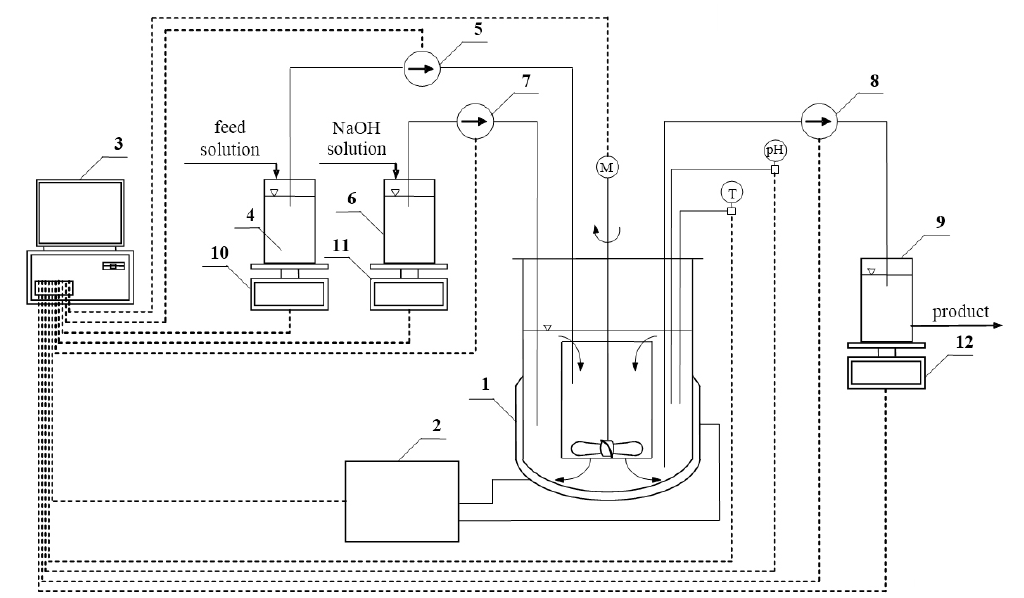
Figure 1: Schematic diagram of the experimental plant. 1 – DT MSMPR type crystallizer with internal circulation of suspension, 2 – thermostat, 3 – PC , 4 – feed reservoir: aqueous solution of NH aqueous solution of NaOH, 7 – proportioner (pump) of NaOH solution, 8 – receiver (pump) of product crystal suspension from the crystallizer tank, 9 – storage tank of a product crystal suspension, 10, 11, 12 – electronic balances, M – stirrer speed control/adjustment, pH – alkaline/ acid reaction control/adjustment, T – temperature